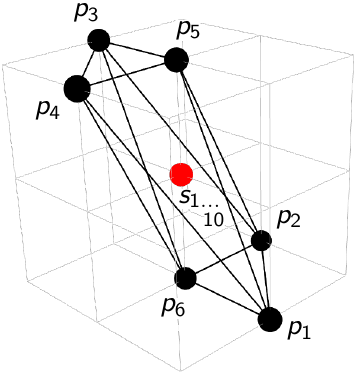
Figure 11 . Toric diagram of Y 2 , 2 ( CP 1 × CP 1 )